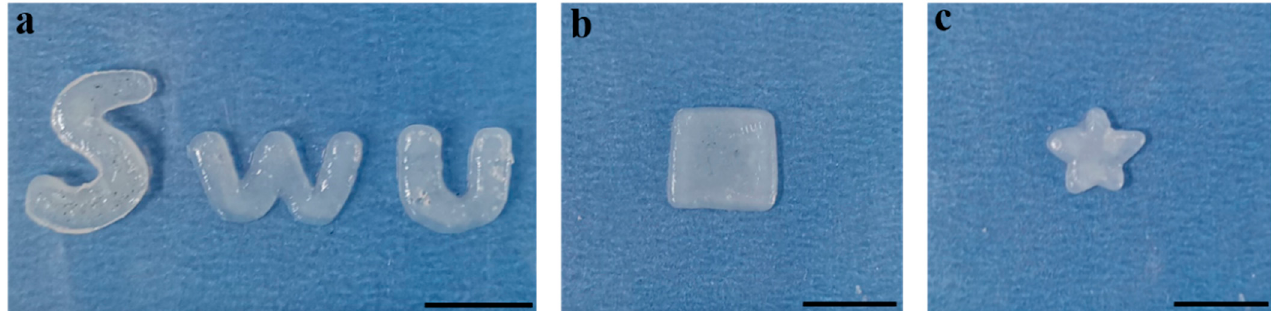
Figure 2. Photographs of the SF/CMCS hydrogel film with different shapes: ( a ) “SWU” logo, ( b ) square, and ( c ) pentagram (scale bar: 1 cm).